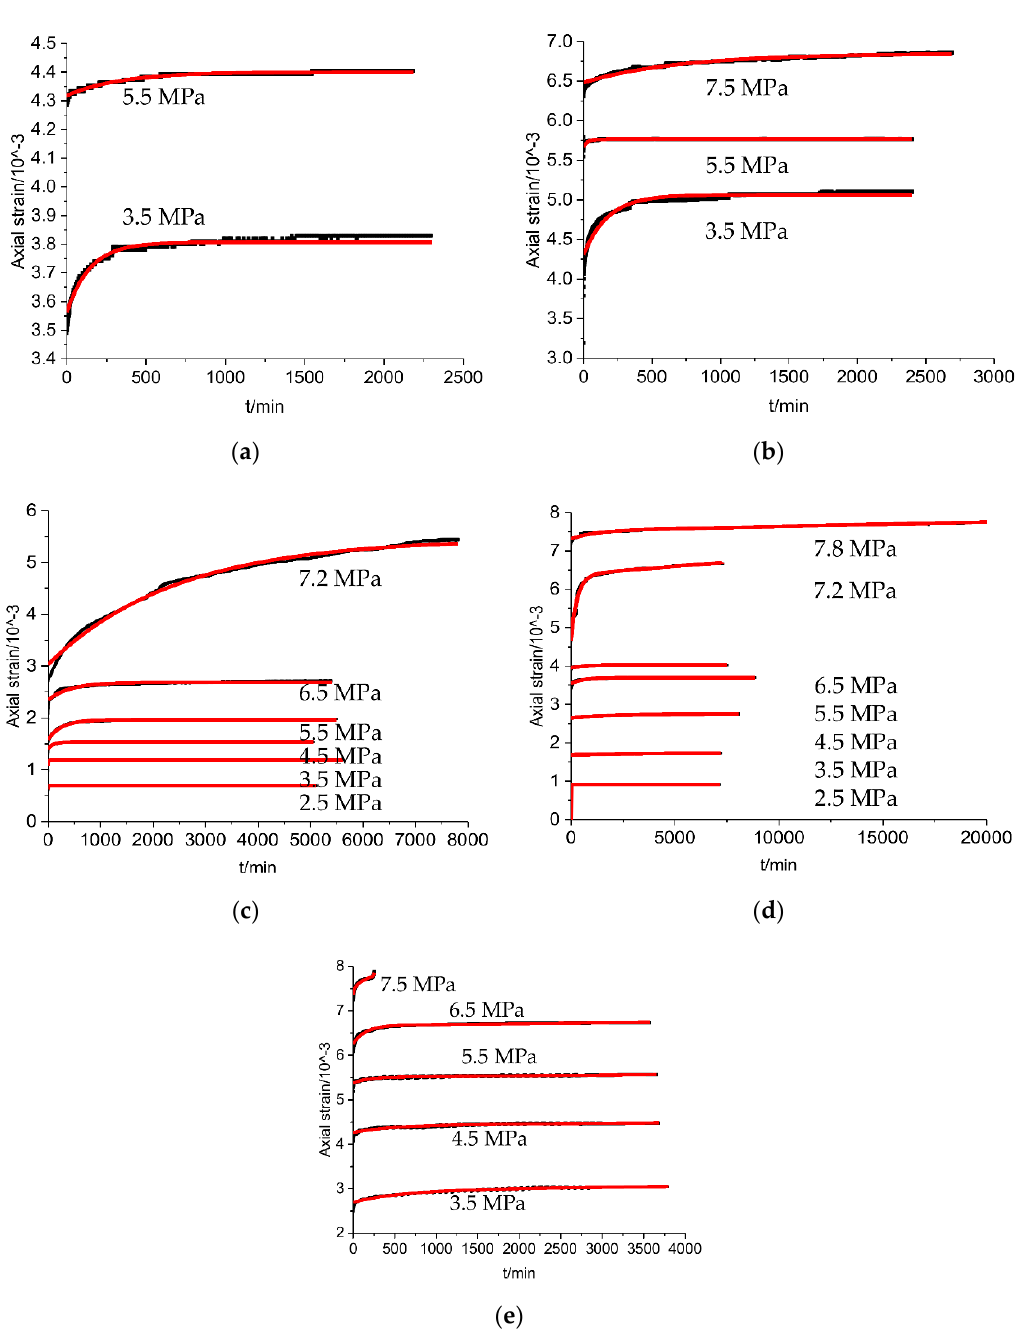
Figure 2. The model validation curves compared to the creep data of lean coal. Black lines refer to the experimental data and the red lines denote the model curves. ( a ) c-1, ( b ) c-2, ( c ) c-3, ( d ) c-4, ( e )